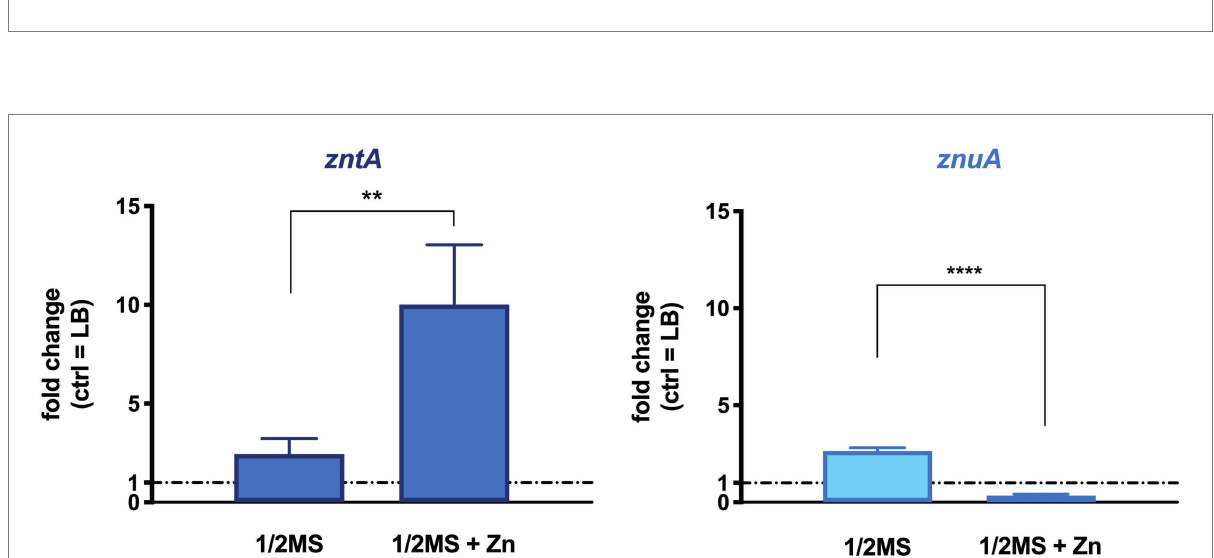
FIGURE 2 Transcription levels of genes of STM recovered from Arabidopsis thaliana infected shoots. RT-qPCR was performed on RNA extracted from plants homogenates, and fold changes were calculated with respect to the gene transcription level from LB-grown STM. Statistical significances were calculated by the Student’s t -test (**** p < 0.0001; ** p < 0.01). The graph is a representative experiment of a two independent